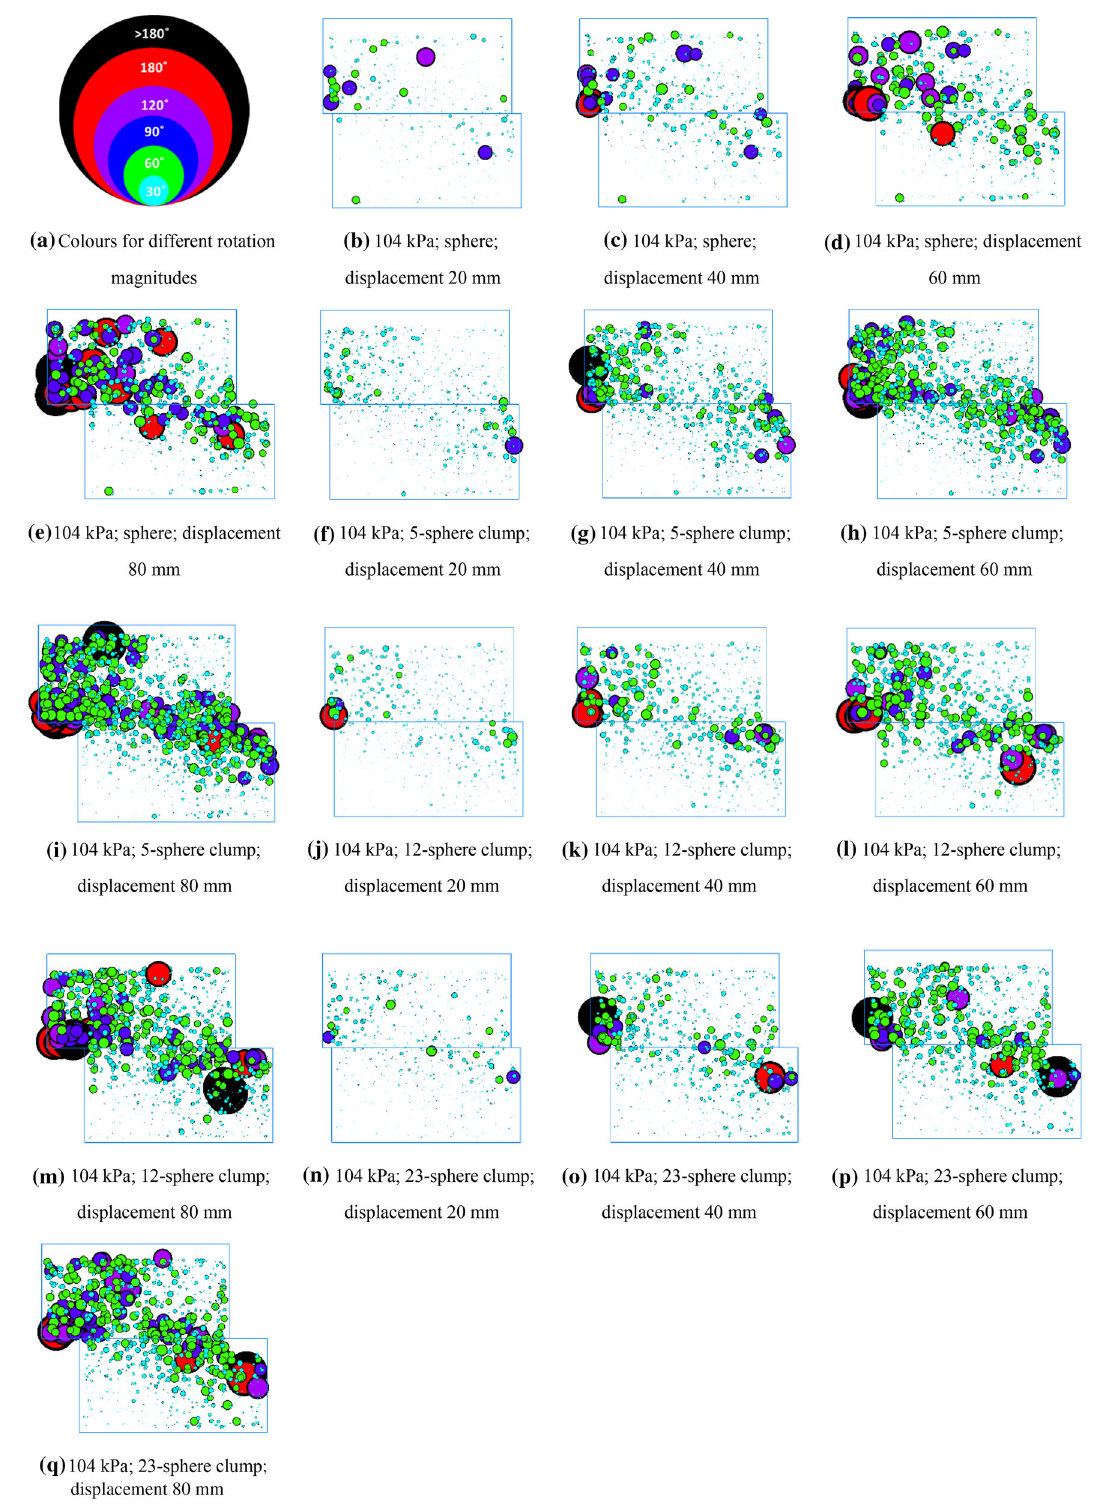
Fig. 10 Particle rotation of using the spheres or